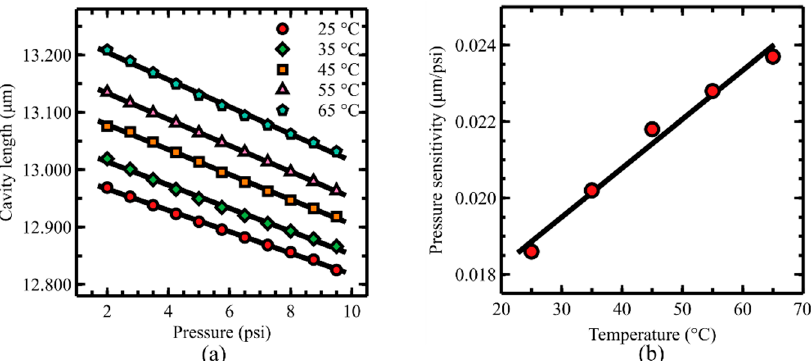
Figure 6. ( a ) Pressure calibration curves at five different temperature and ( b ) a temperature calibration curve at 2 psi.